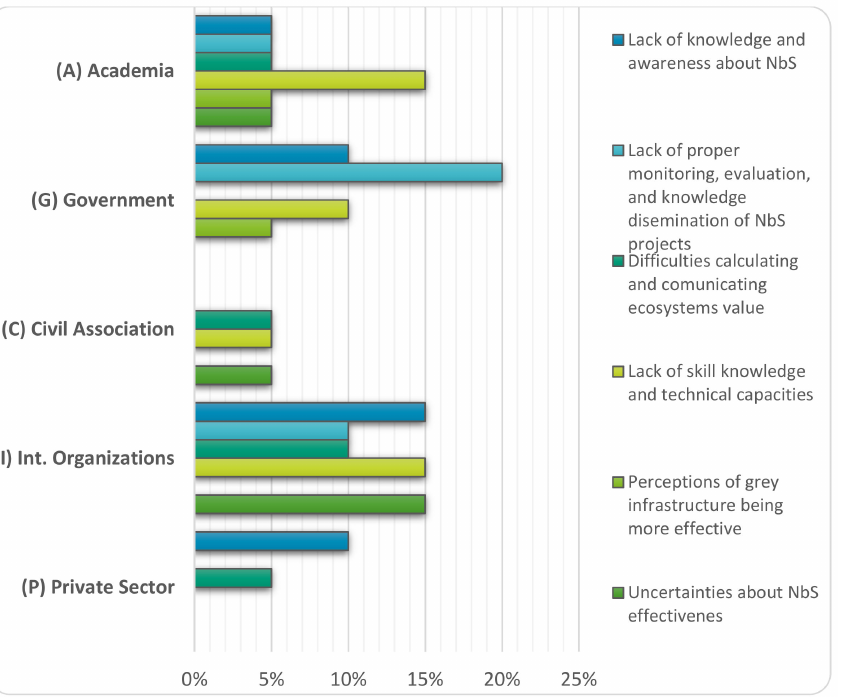
Figure 3. Knowledge and capacity barriers perceived per group of stakeholders. Source: Authors